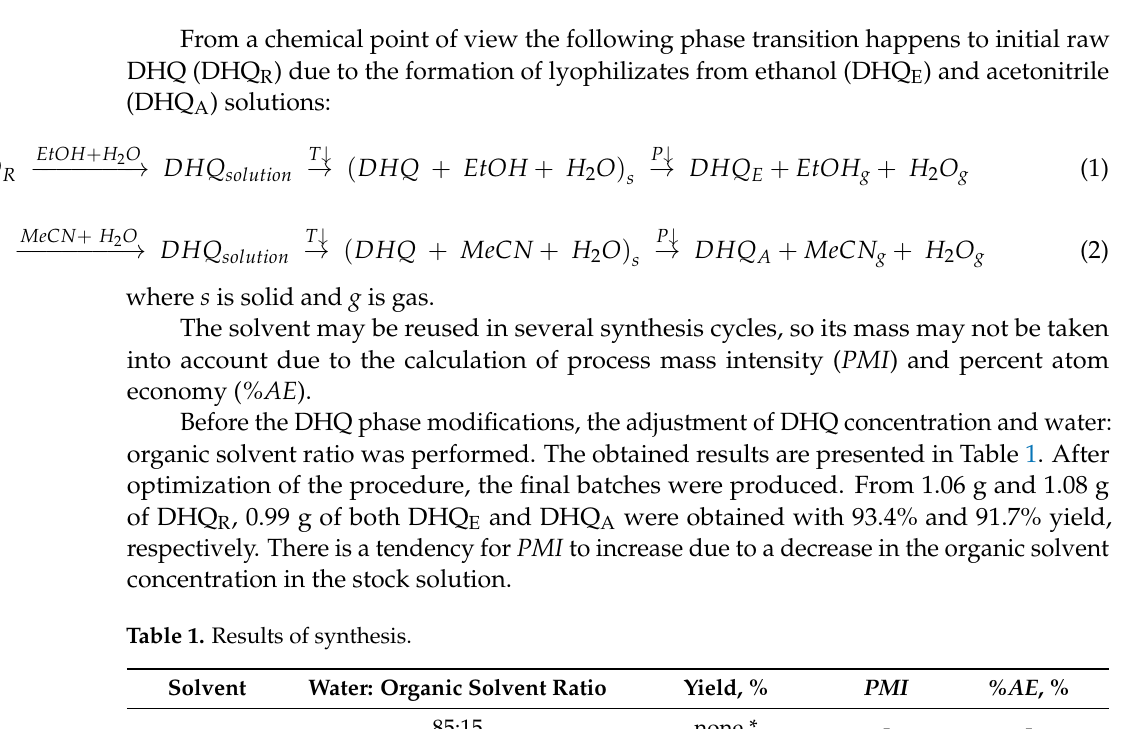
Figure 2. “Green” features of taxifolin lyophilization.